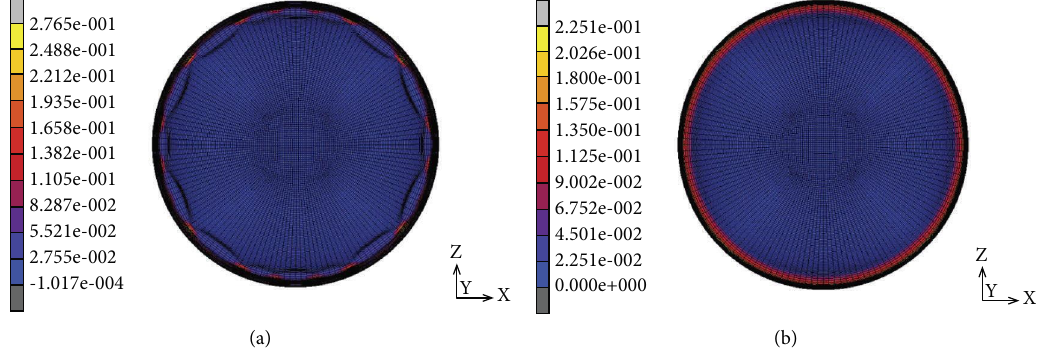
Figure 12: Comparisons of the shape and the plastic strain for the fourth group diaphragms. (a) Tickness: 0.4mm–0.6 mm; (b) Tickness: 1.0mm–1.5